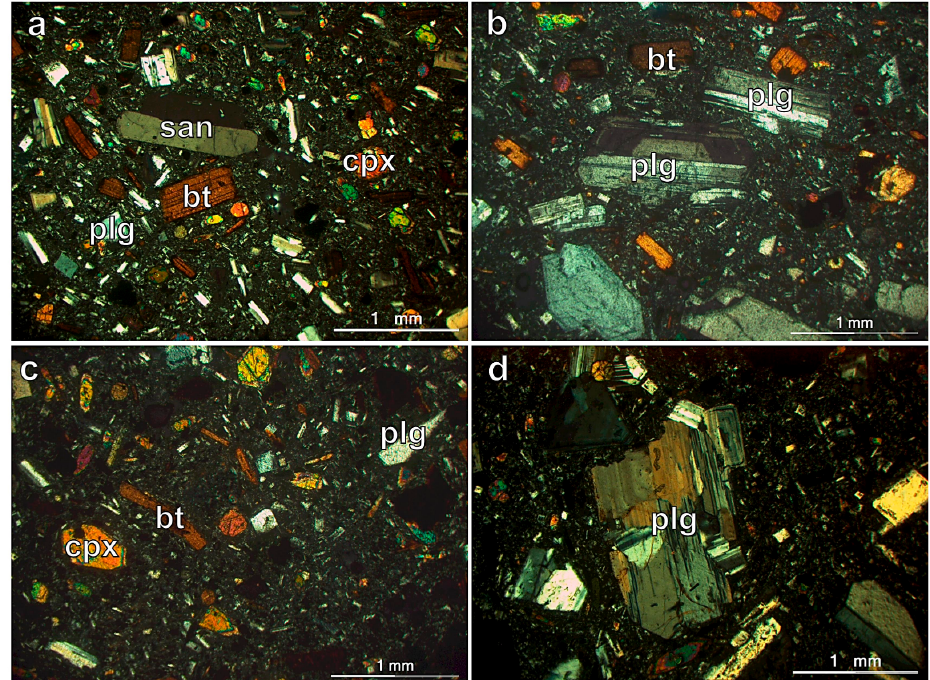
Figure 3. Photomicrographs of andesites: ( a ) porphyritic texture with plagioclase, K-feldspar (sanidine), clinopyroxene and biotite phenocrysts (sample BE.89, XPL); ( b ) porphyritic texture with plagioclase and biotite phenocrysts; ( c ) phenocrysts of oxidised biotite, clinopyroxene and zoned plagioclase in a microcrystalline to glassy groundmass (sample BE.88, XPL); ( d ) phenocryst of a zoned and altered to albite plagioclase surrounded by glassy groundmass (sample BE.82, XPL). Abbreviations: